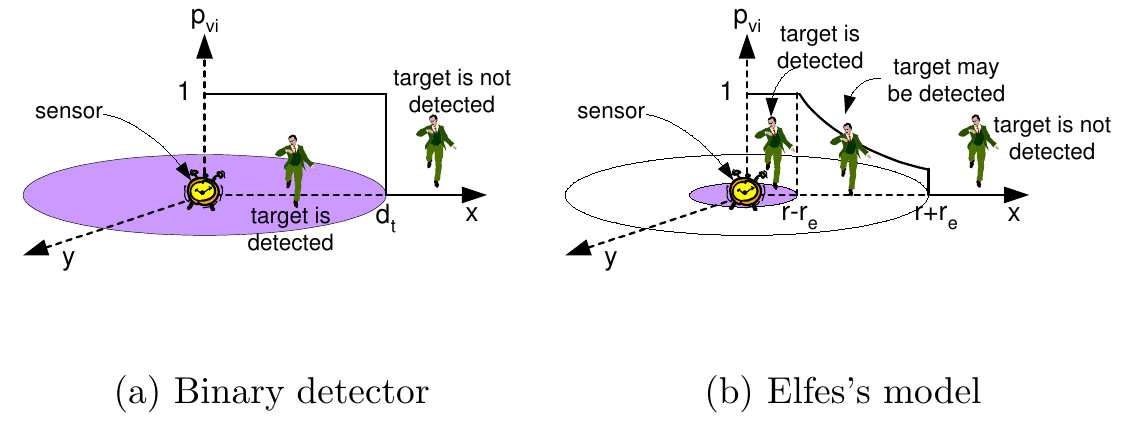
Figure 2. Sensor detection models [15]. ( a ) Binary detector. ( b ) Elfes’s